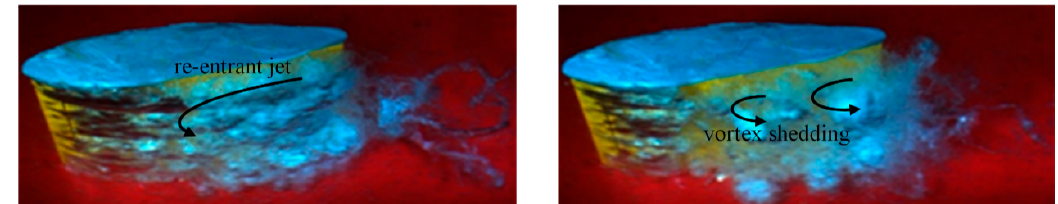
Figure 10. Re ‐ entrant jet and vortex shedding observed in the experiment ( σ = 0.65, α = 60°). Figure 10. Re-entrant jet and vortex shedding observed in the experiment ( σ = 0.65, α = 60 ◦